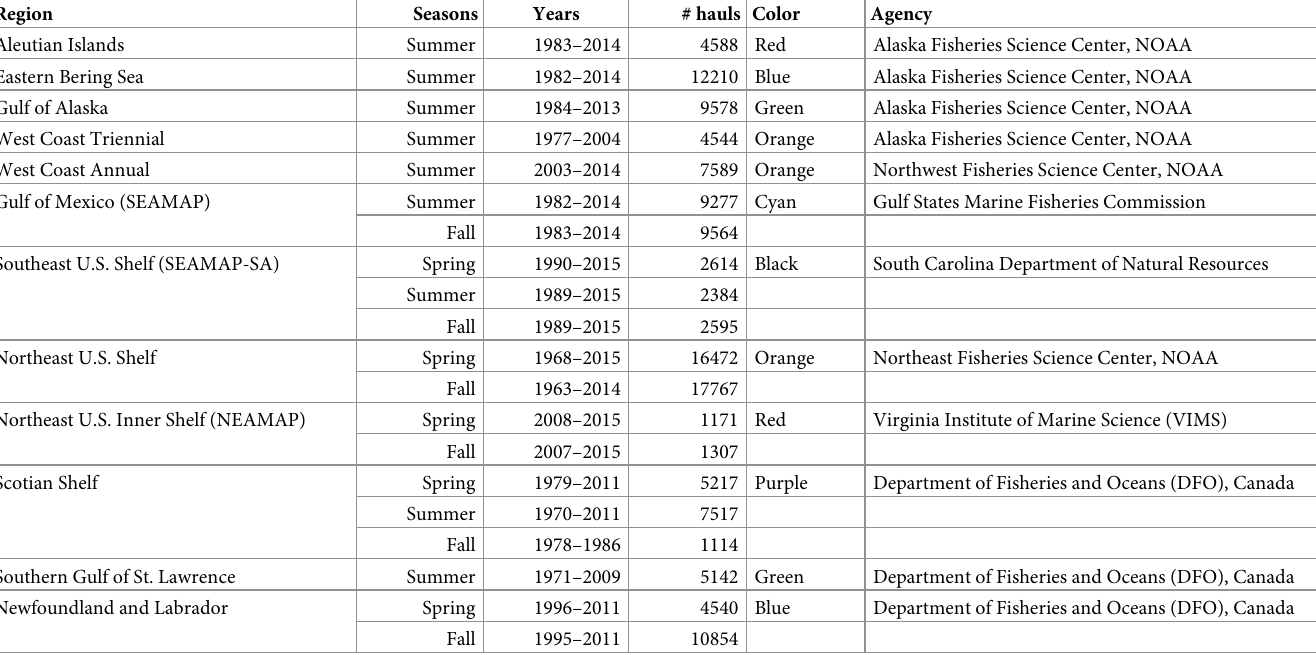
Sea surface and bottom water temperatures for each haul were obtained from the Simple Ocean Data Assimilation (SODA3.3.1) reanalysis of ocean climate, which provides a global reconstruction of historical ocean temperatures [43]. SODA3.3.1 has a spatial resolution of 28 Table 1. Information for North American bottom trawl